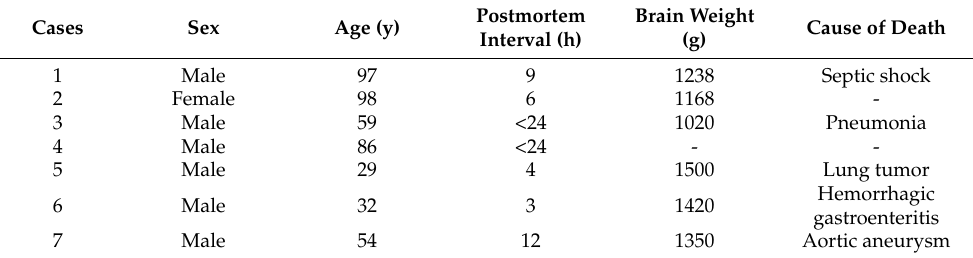
Table 1. Clinical data of the human